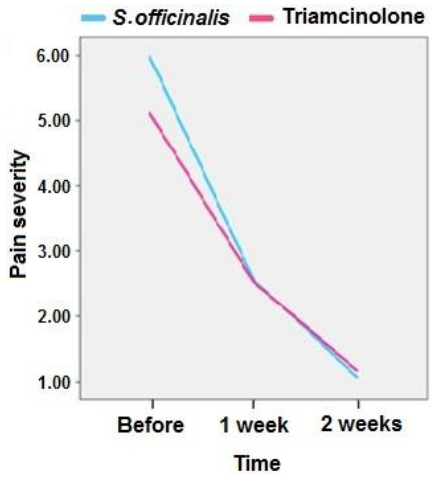
Figure 1. Standard deviation of pain level for both drugs at different times.